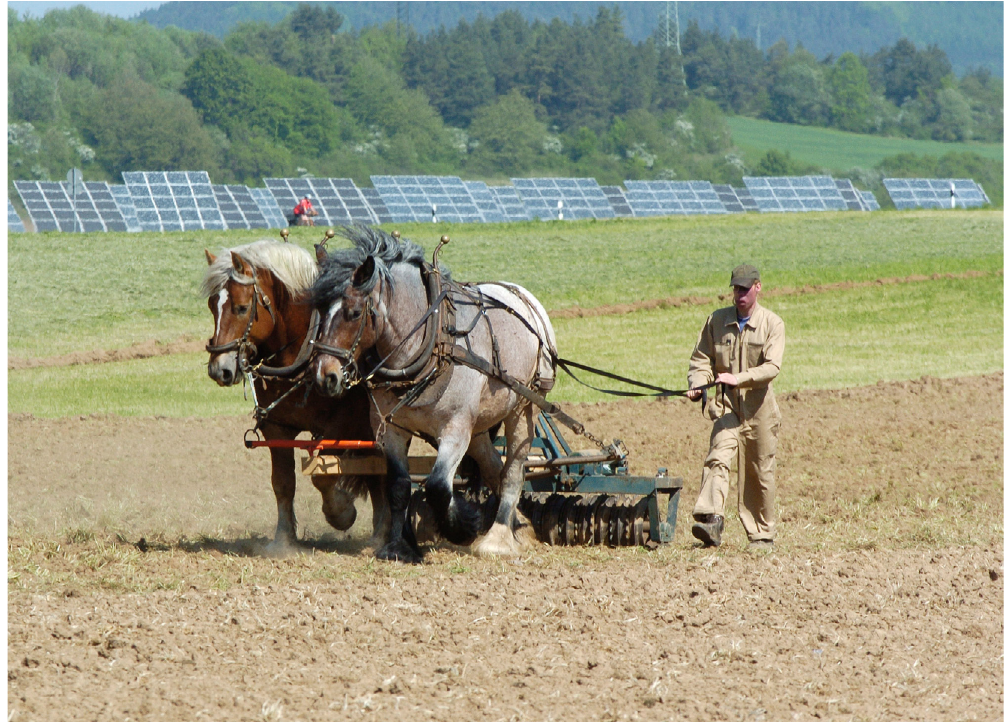
Figure 2: Modern use of draught horses in an integrated organic farm in Germany. The need to avoid dependence on fuel fossils led many farmers to reintegrate animal energy in the production models, as well as other renewable sources of energy such as solar energy (photo courtesy of Erhard